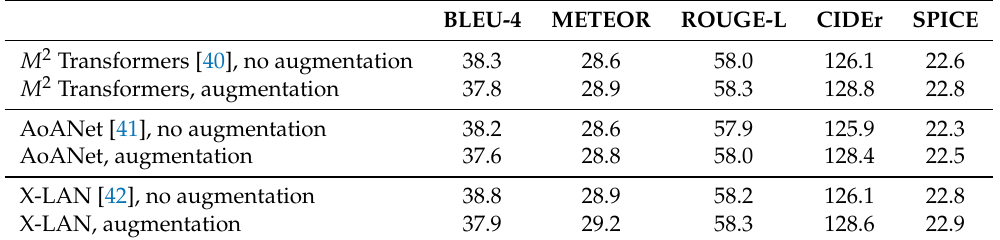
X-LAN [42], no augmentation 38.8 X-LAN,